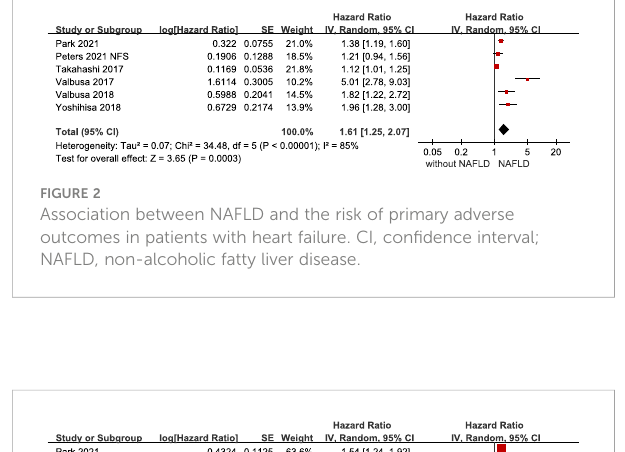
(20) used both FIB-4 and NFS to de fi ne NAFLD, we used NFS for the main analysis fi rst, and then included FIB-4 in the sensitivity